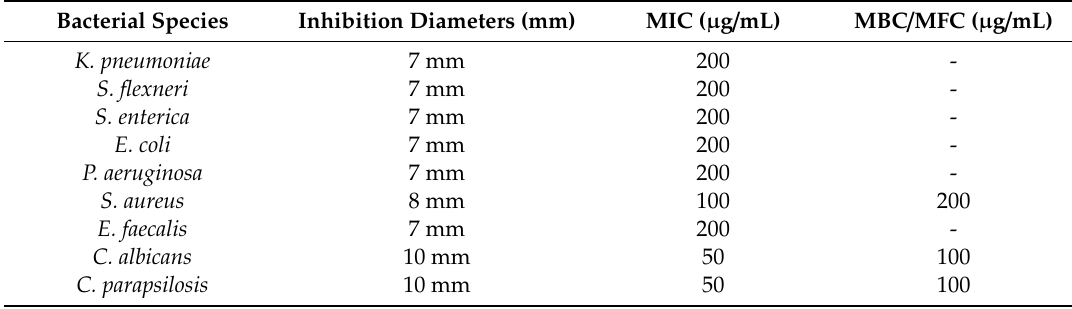
Table 2. Antimicrobial activity of the OB extract.